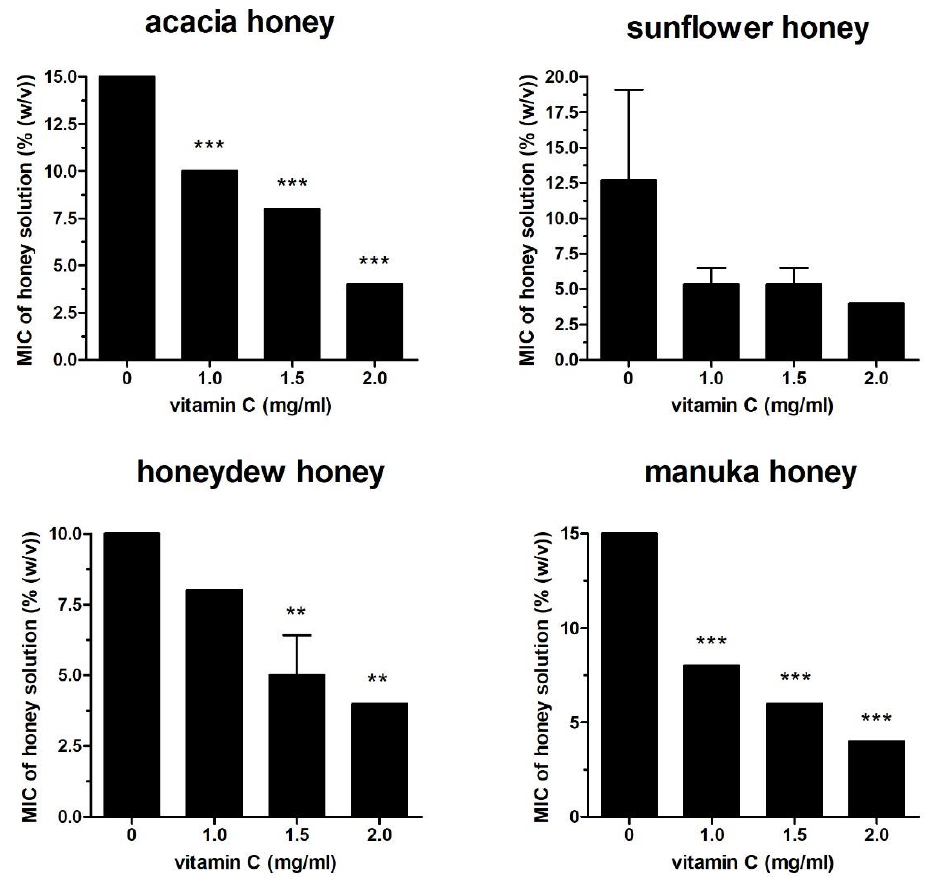
Figure 1. Antibacterial activities of honey samples (acacia, sunflower, honeydew, and manuka honey) supplemented with Vit C at sub-inhibitory concentrations against Pseudomonas aeruginosa isolates. The activity was determined with a MIC assay. The MIC was defined as the lowest concentration of honey solution (%) that inhibited bacterial growth. The data are expressed as mean values with standard deviations. ** P < 0.01 and *** P < 0.001.